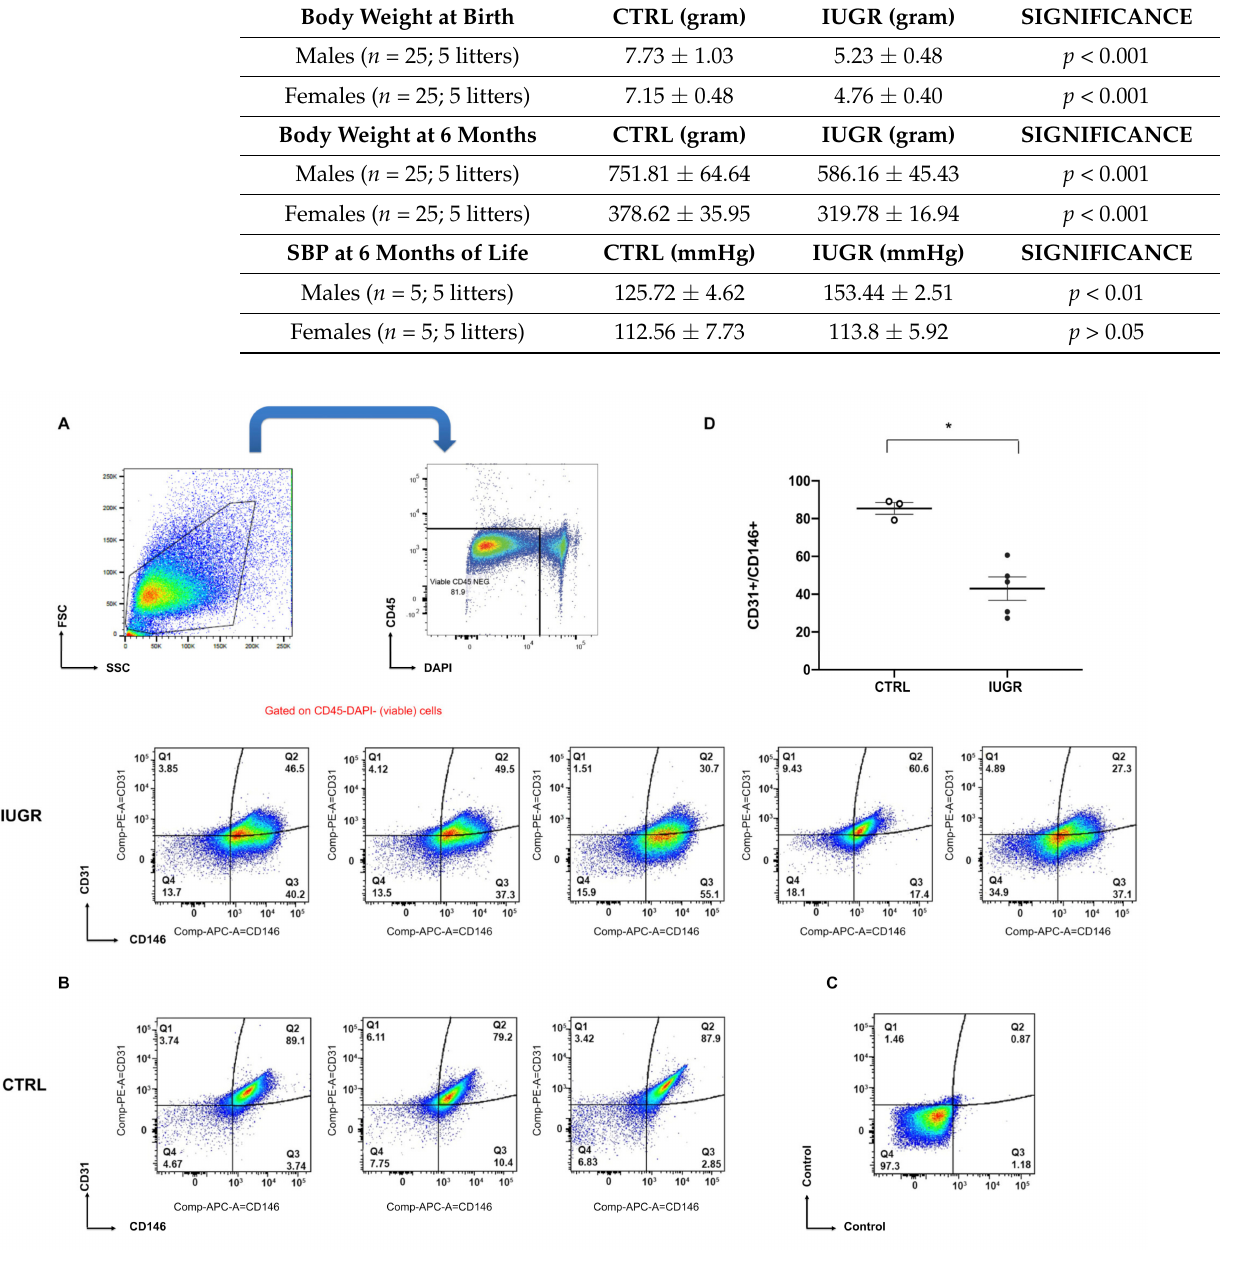
Table 1. Body weight at birth and at 6 months of life, and systolic blood pressure (SBP) at 6 months of age in CTRL and IUGR males and females.